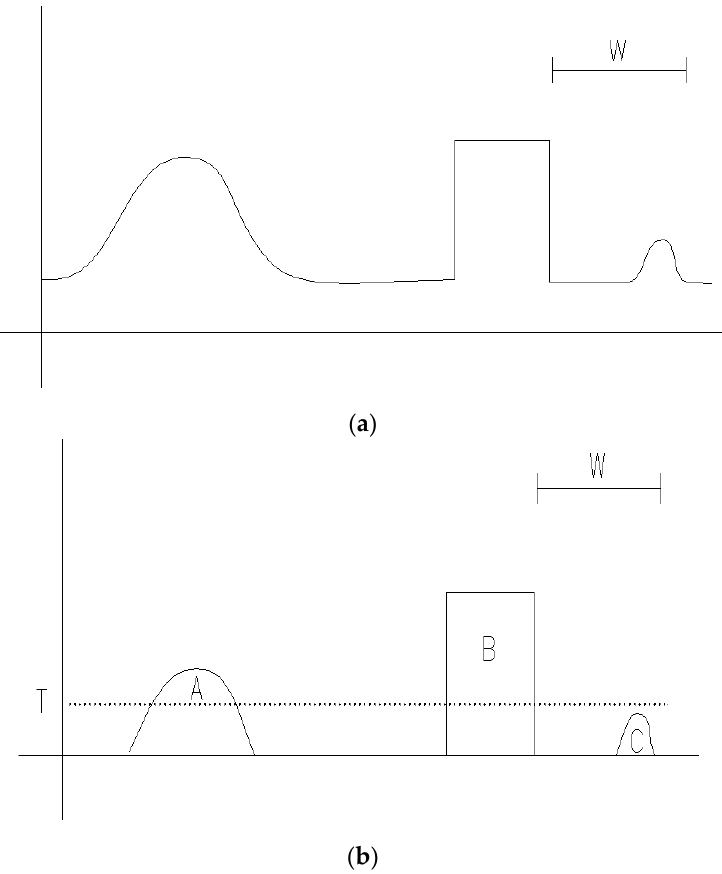
Figure 1. Example of traditional morphological filtering algorithm for removing non-ground points: ( a ) original point cloud; and ( b ) filtering results with threshold T.